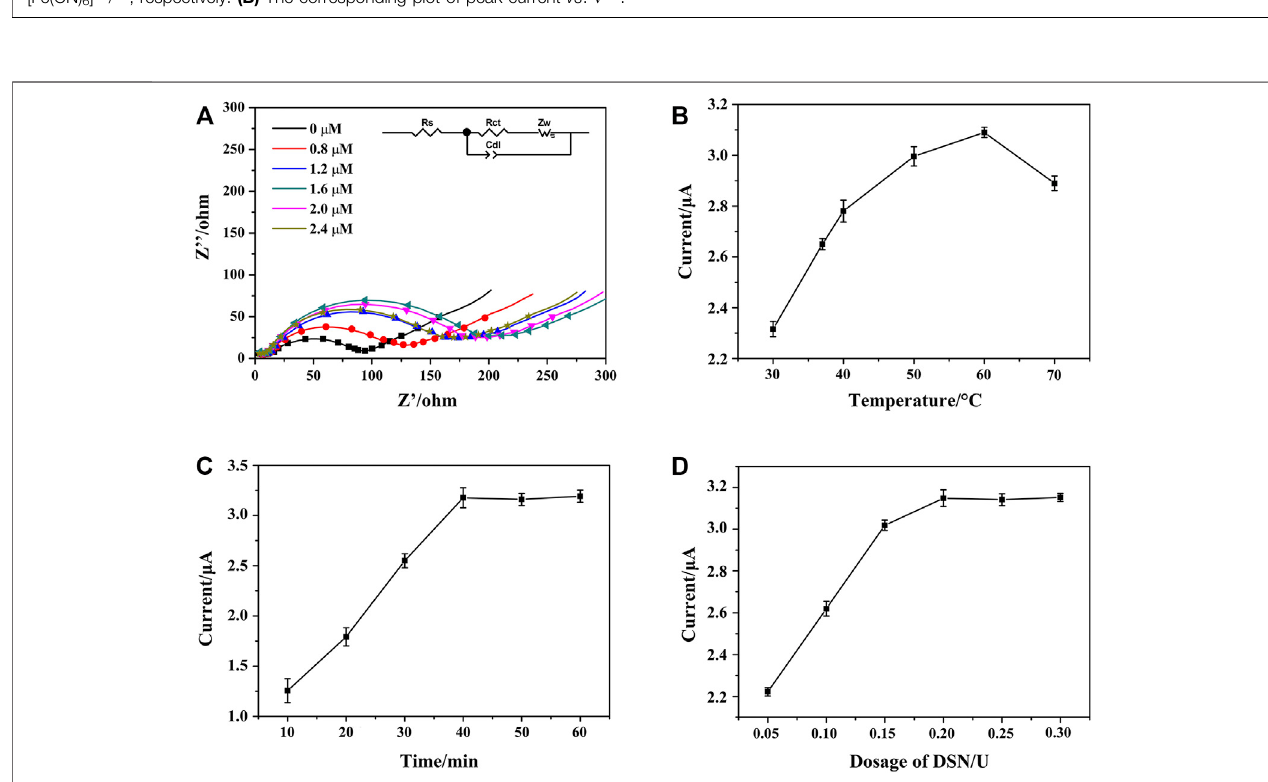
FIGURE6|(A) NyquistplotsofHP1/AuNPs/ZIF-8/ITOimmobilizedwithdifferentconcentrationsofHP1,whichrecordedinPBScontaining5.0 mM[Fe(CN) 6 ] 3 − / 4 − . Effects of DSN catalytic nicking reaction parameters of (B) reaction temperature, (C) reaction time, and (D) DSN dosage on the peak current of HCR/ssDNA/HP1/ AuNPs/ZIF-8/ITO in the presence of NADH and Thi, respectively.